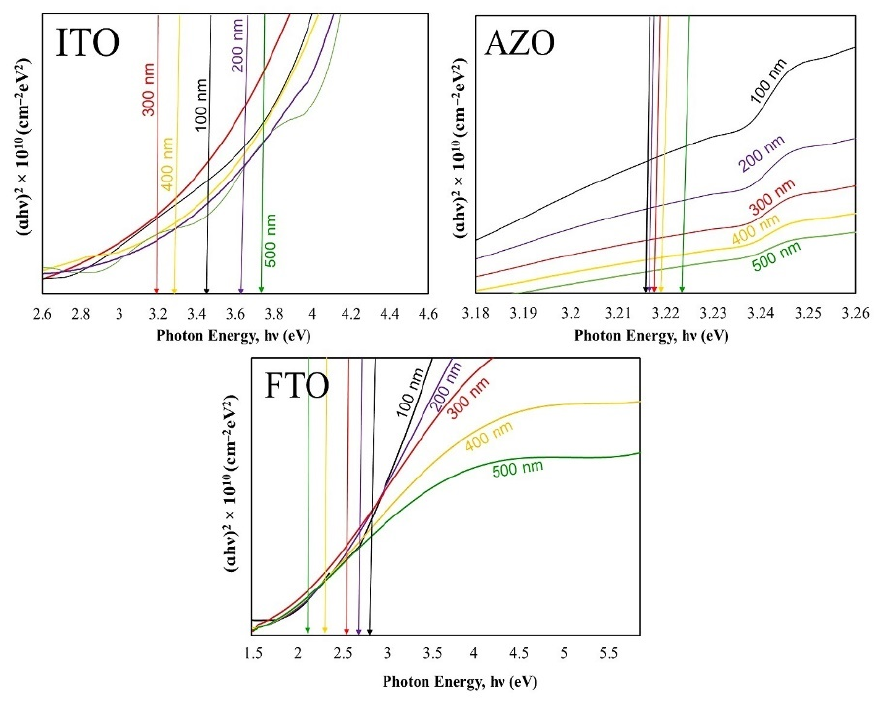
Figure 6. Optical bandgap using OPAL2 for TCO (different thickness).